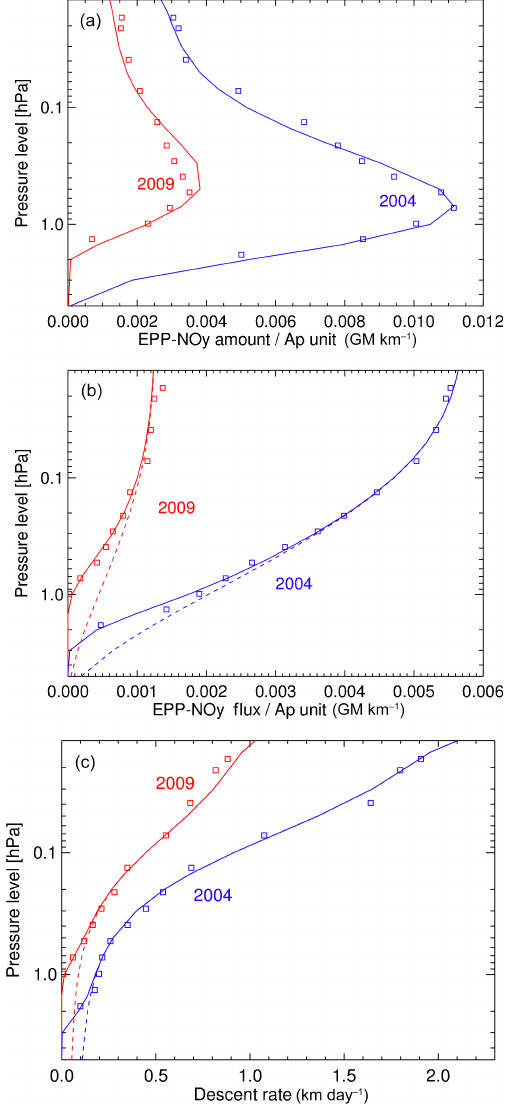
Figure 5. (a) Parameterized (solid) and adjusted (symbols) resid- ual maximum amounts N ES m (z) for 2004 (blue) and 2009 (red). (b) Parameterized and adjusted maximum fluxes F ES m (z) . The ) e F ES m (z) (i.e., without correction in dashed lines represent (cid:56)(t ES 0 the vicinity of equinox). (c) Parameterized and adjusted descent ) e ω ES m (z) (i.e., with- rates ω ES (z) . The dashed lines represent (cid:127)(t ES 0 out correction in the vicinity of equinox).